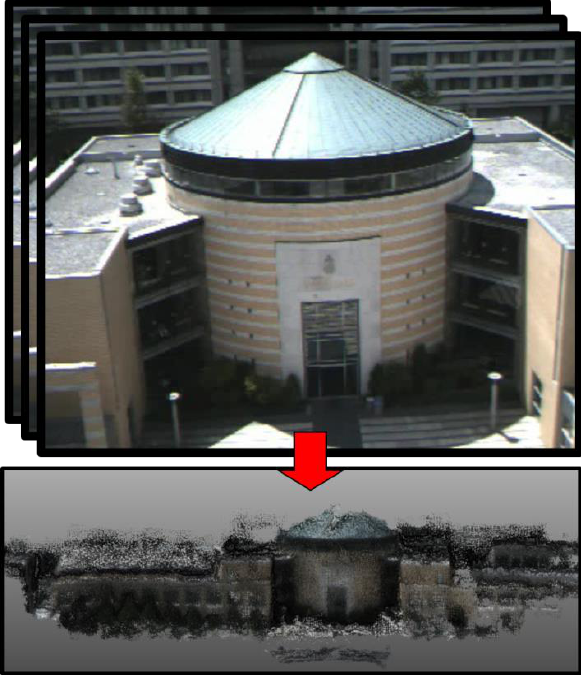
Figure 6: VisualSFM and SURE used to generate a dense point cloud of Vari Hall from the sUAMS' video imagery. Firstly the point clouds were segmented into groups of similar normal vectors. Figures 7 (the Lassonde building) and 8 (Vari Hall) show the three groups: points with normal vectors (1) pointing in the positive Y direction (±45 o ), (2) pointing in the negative X direction (±45 o ), and (3) pointing in the positive X direction (±45 o ). For each group, a point-plane ICP was applied, and points with the smallest residuals were used to further refine the estimated transformation parameters. Figure 9 shows the registered point clouds for the Lassonde building (top) and Vari Hall (bottom).